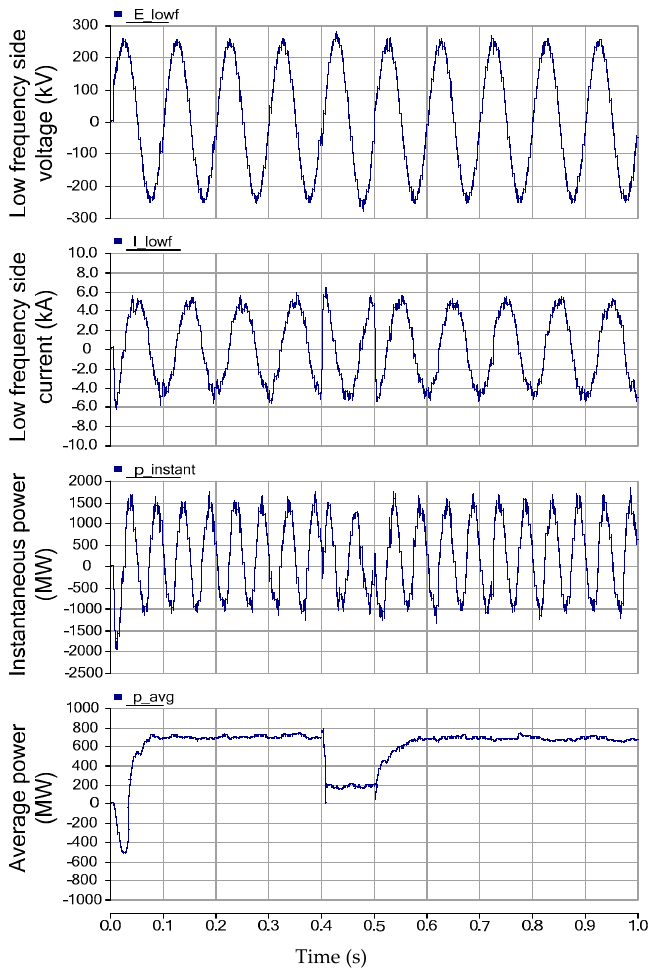
Figure 19. Simulation result of a sudden change of reference power.